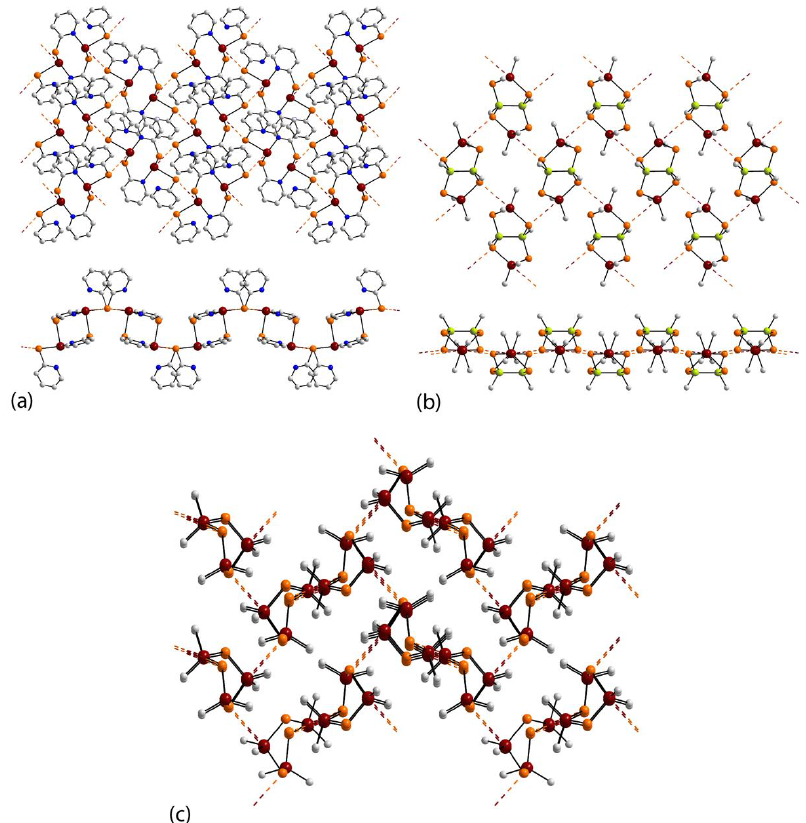
Figure 3. Supramolecular aggregation via Sn ··· Se secondary bonding in ( a ) 11 {ZOPWIK; d(Sn ··· Se) = 3.62 Å}, ( b ) 12 {UCOREJ; 4.01 Å}, and ( c ) 13 {HMCTSS; 4.01 Å}. Additional color code: silicon,